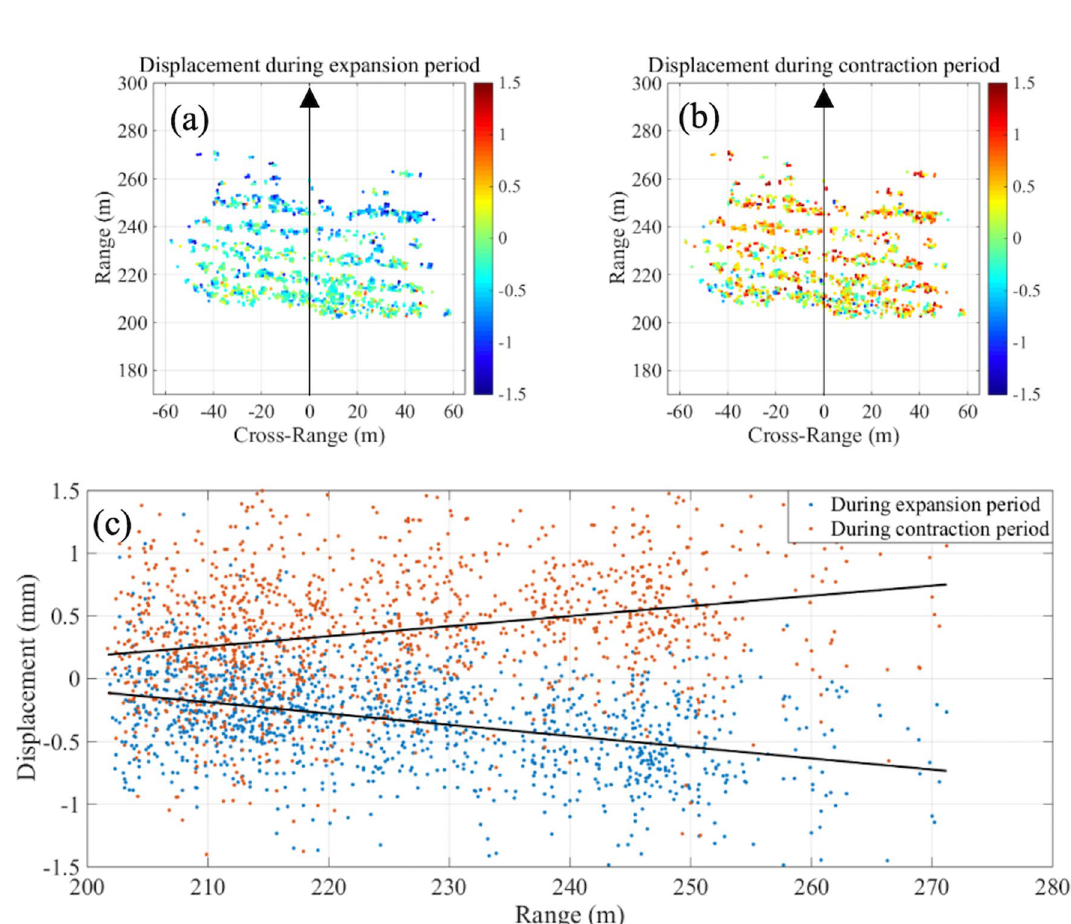
Figure 5. Slope displacements measured by the GB-SAR during ( a ) the maximum expansion period (16:14 on 30 September 2018), and ( b ) the maximum contraction period (07:29 on 3 October 2018). ( a ) and ( b ) show the displacement maps, where range is the distance from the GB-SAR (lower range corresponds to the toe of the slope, higher range corresponds to the crest, and cross-range is in the direction of the width of the slope, zeroed at the location of the radar). ( c ) Displacement plotted against range with dark lines showing trends during the expansion/contraction periods, i.e. increasing cyclic displacements near the crest compared to the toe of the